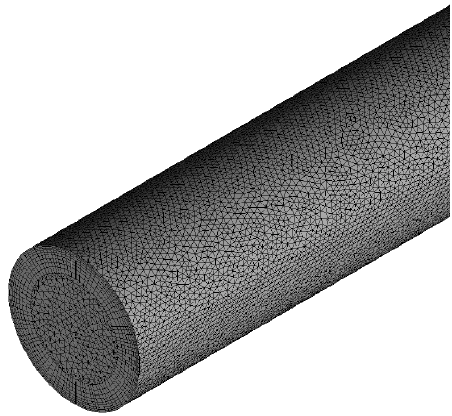
Figure 6. Computational mesh for the fluid